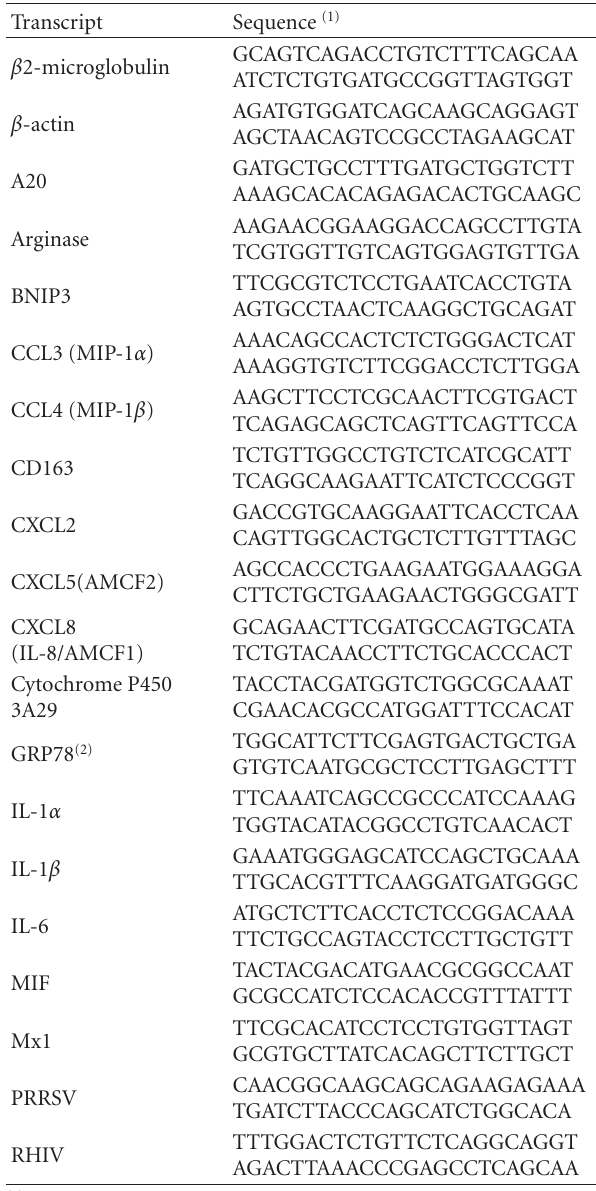
Table 3: Real-time PCR primer